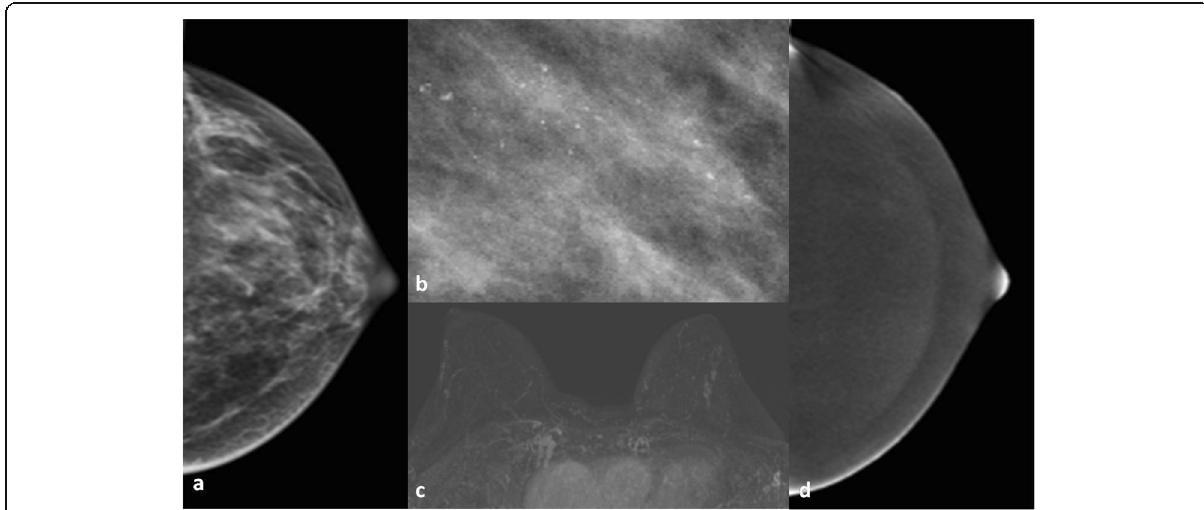
Fig. 5 Sixty-six-year-old patient came for screening with strong positive family history. SM revealed left breast UOQ segmental microcalcifications with no underlying lesions by ultrasound ( a , b ). MRI showed left breast linear faint non-mass enhancement ( c ). CEM showed no significant contrast uptake ( d ). The final diagnosis was atypical ductal hyperplasia